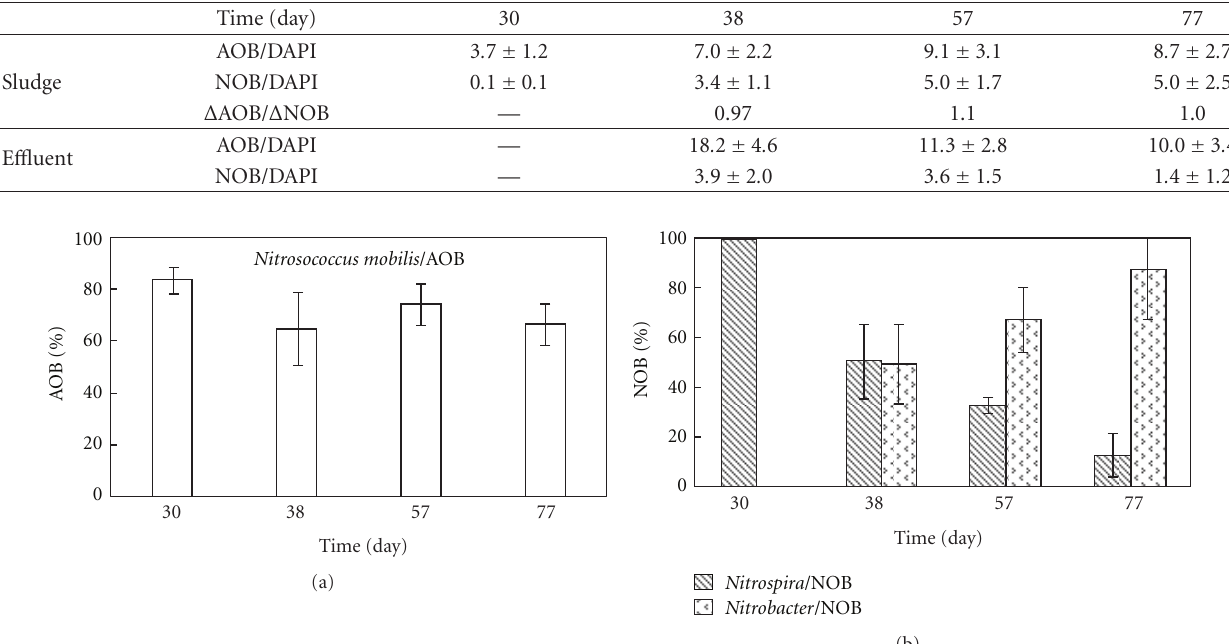
Figure 4: (a) Community structure shifts in AOB in the main-stream reactor. (b) Community structure shifts in NOB in the main-stream